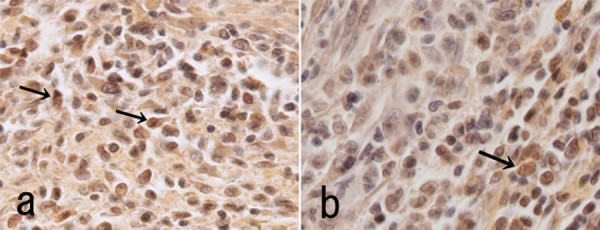
Immunohistochemical analysis of BMP-4 in skeletal muscle. Immunohistochemical detection of BMP-4-positive cells 5 days after the combined transfer of the BMP-2 and BMP-7 genes (a), or the BMP-2 gene alone (b). The positive cells (arrows) were numerous in the matrix between the muscle fibres in the muscle transfected with the combined BMP genes compared with muscle transfected with BMP-2 alone.